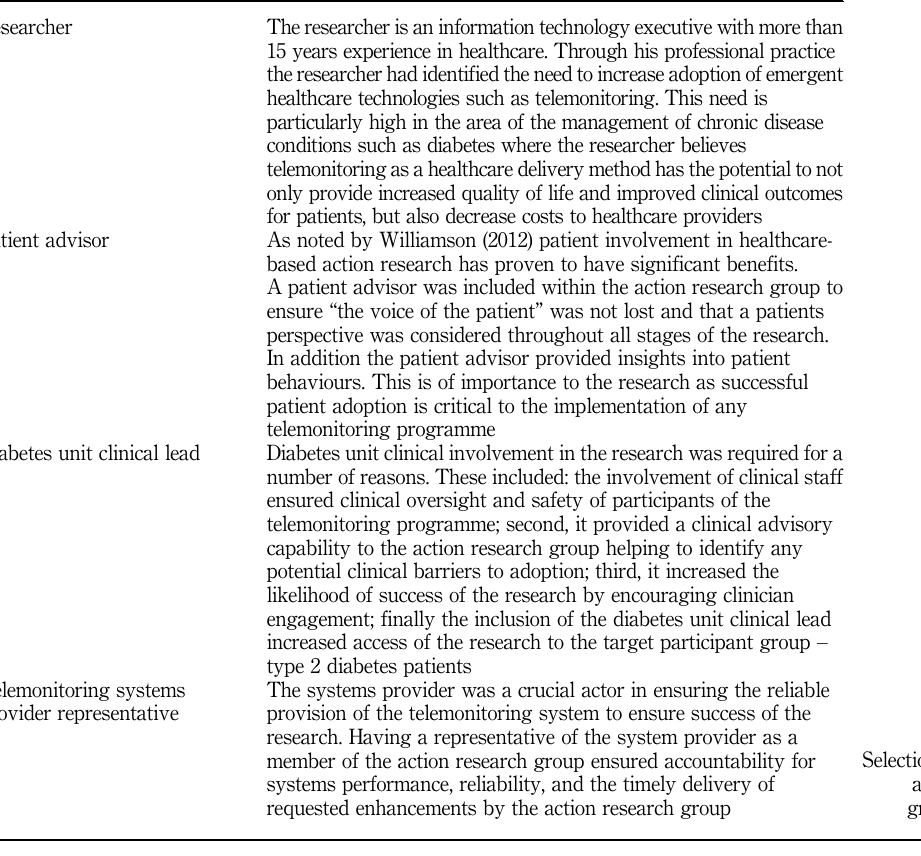
Table III. Selection rationale